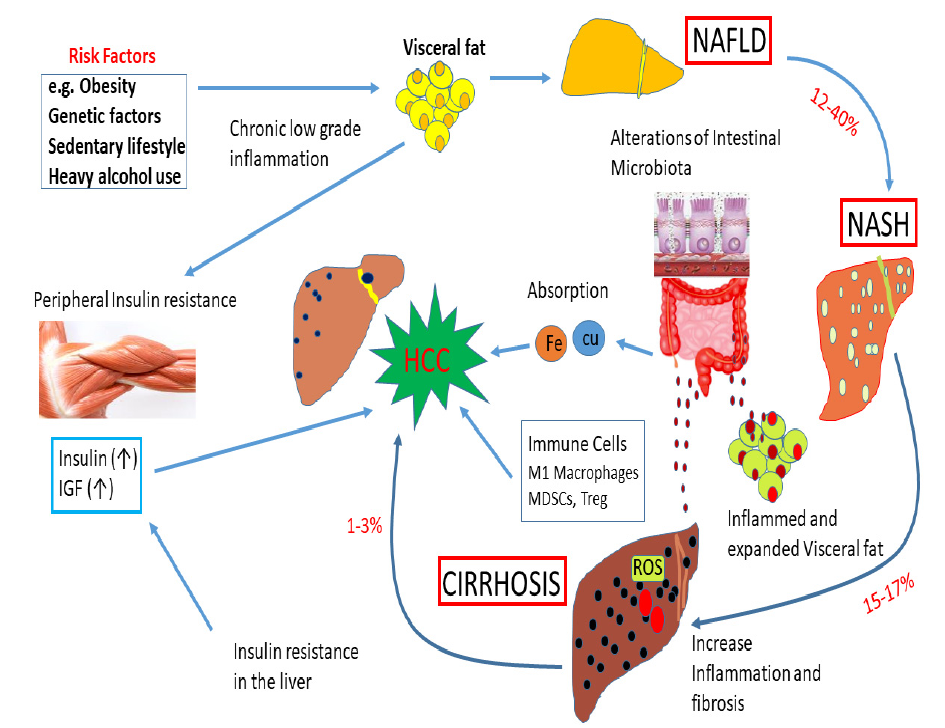
Figure 4. Impact of obesity, genetic factors, and a sedentary lifestyle on liver diseases. Obesity, genetic factors, and a sedentary lifestyle enhance the deposition of visceral fat. These events can play a significant role in the development of non-alcoholic fatty liver disease (NAFLD). About 12–40% of cases of NAFLD develop into NASH. About 15–17% of NASH cases may advance to cirrhosis due to an increase in inflammation and fibrosis. A subset of cirrhosis (1–3%) will finally advance to hepatocellular carcinoma (HCC). High levels of insulin and IGF-1 during insulin resistance can accelerate the development of HCC. Alterations of intestinal microbiota can cause inflammation and visceral fat deposition. The absorption of Fe and Cu in the gut, and immune cells, M1 macrophages, myeloid-derived suppressor cells (MDSCs), and Treg can regulate the development of HCC. In addition, ROS and fatty acid ethyl esters induce cellular